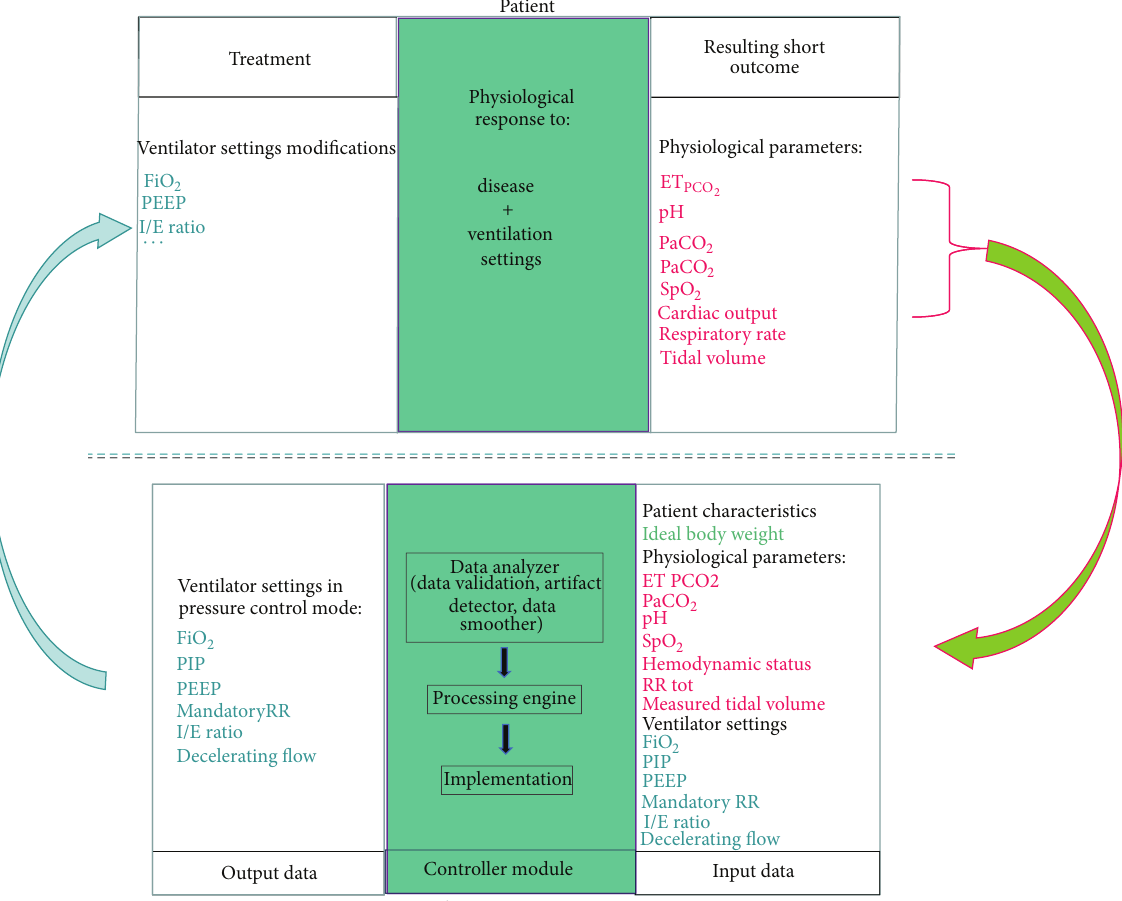
Figure2:SchematicpresentationoftheinteractionbetweenasimulatorandaclinicaldecisionsupportsystemduringtheR&Dphase.PaCO 2 : partial pressure of carbon dioxide, ET PCO 2 : end-tidal PCO 2 , PaO 2 : partial pressure of oxygen, SpO 2 : saturation of peripheral oxygen, FiO 2 : fraction of inspired oxygen, PIP: positive inspiratory pressure, PEEP: positive end-expiratory pressure, I/E ratio: inspiratory/expiratory ratio, RR: respiratory rate, CDSS: clinical decision support system.